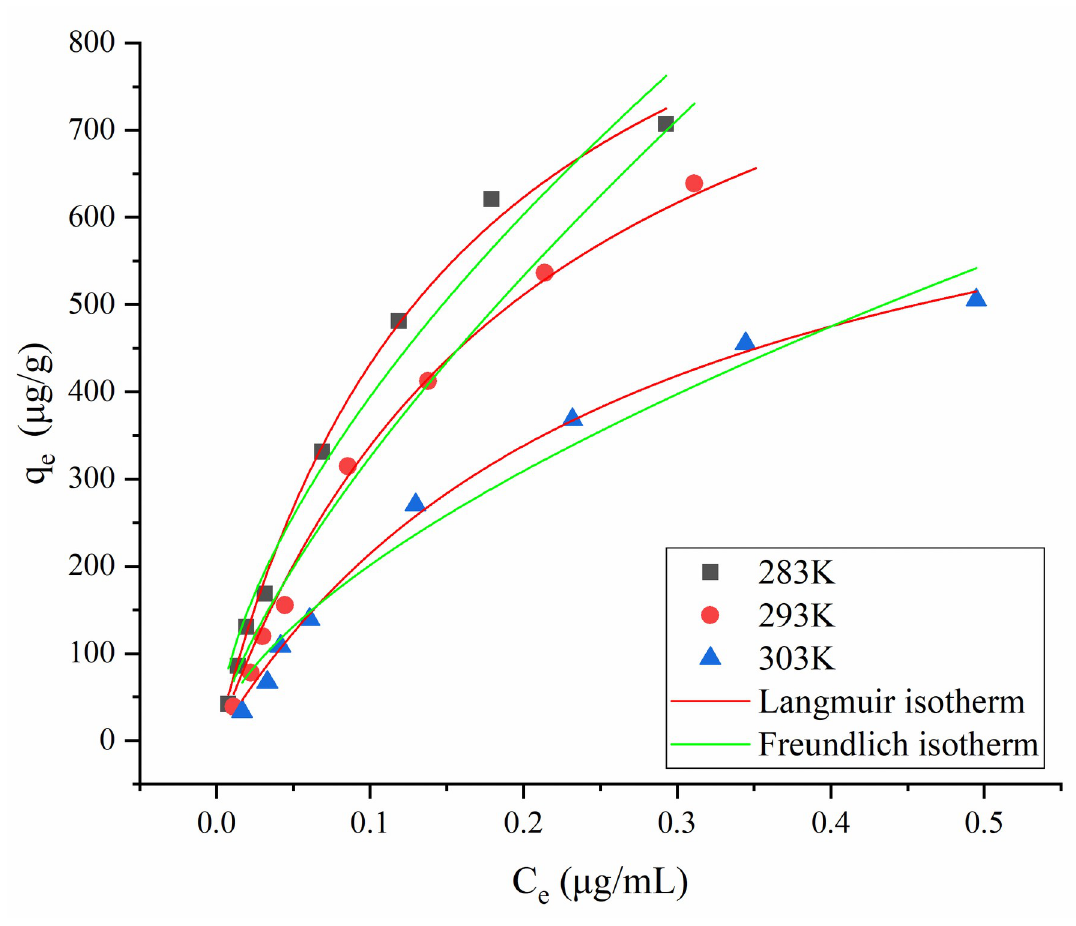
Fig 7. Isothermal AFB1 adsorption on MMS in oil.